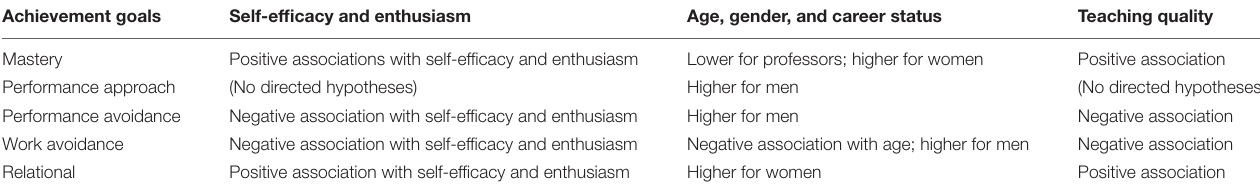
TABLE 1 | Overview of the hypotheses concerning the relationships of instructors’ achievement goals with other